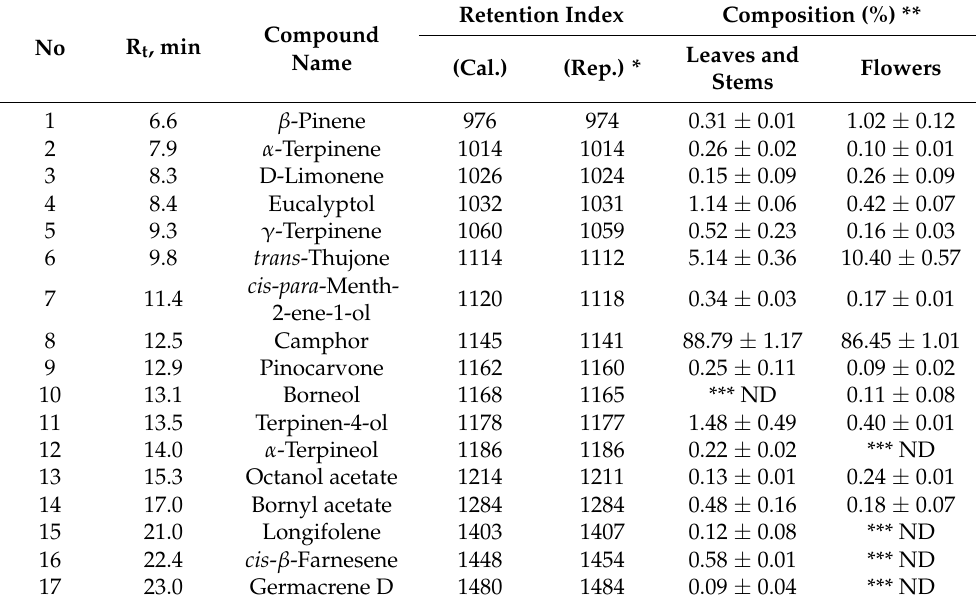
Table 1. Chemical composition of C. anthemoides essential